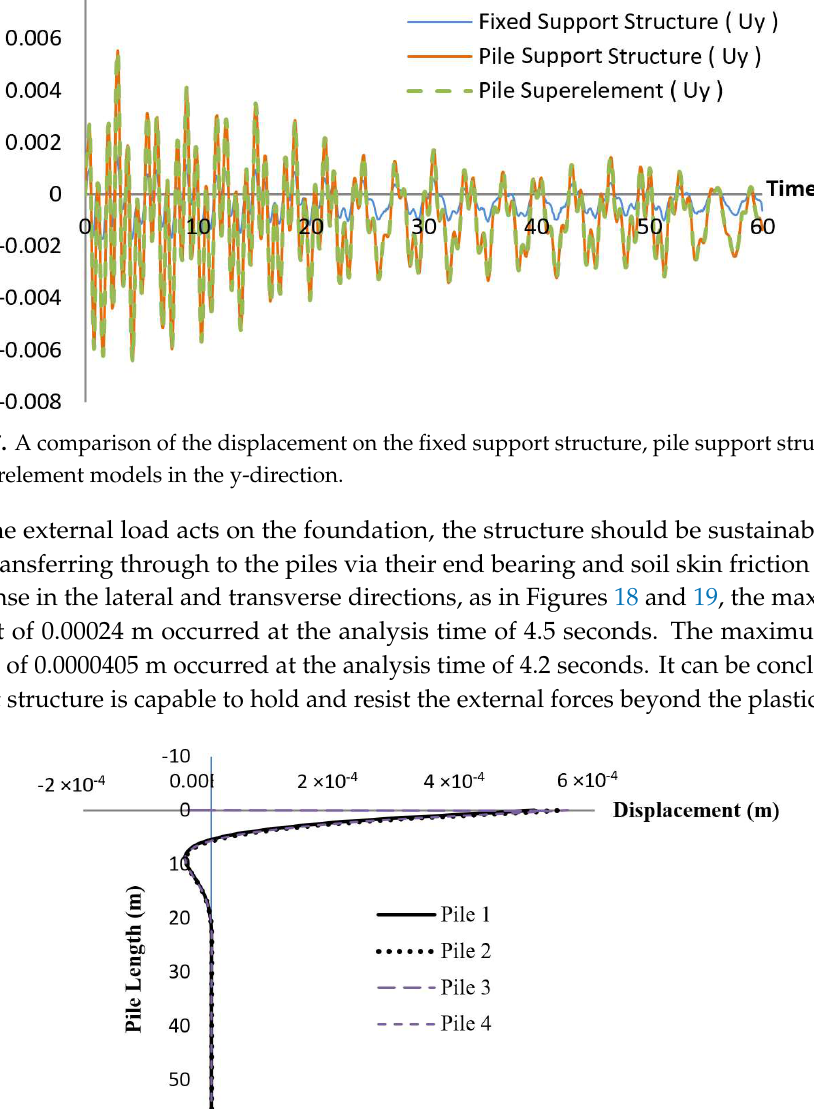
Figure 16. A comparison of the displacement on the fixed support structure, piled-support structure and pile superelement models in the x-direction.